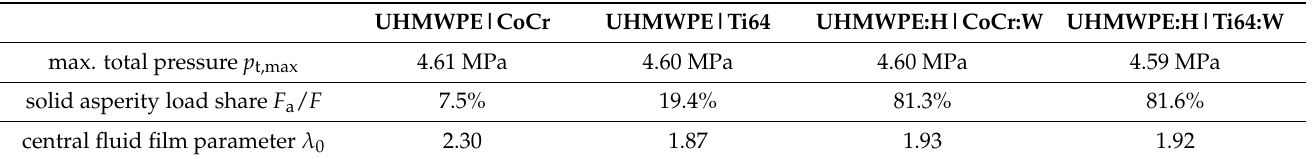
Figure 4. Total pressure ( a ) and lubricant gap ( b ) distribution over the contact area and in the y = 0 cross-section ( c ) for the UHMWPE|CoCr-pairing. Table 4. Computed maximum total contact pressure, solid asperity load share and central fluid film parameter for the reference as well as the coated pairings.